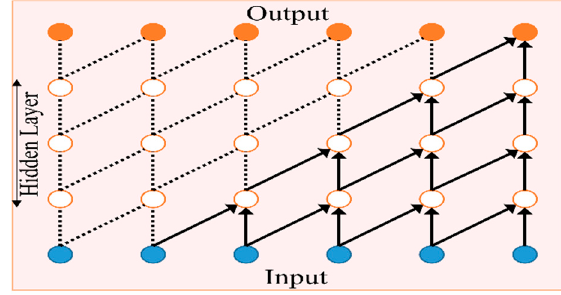
Figure 2. Causal convolution.